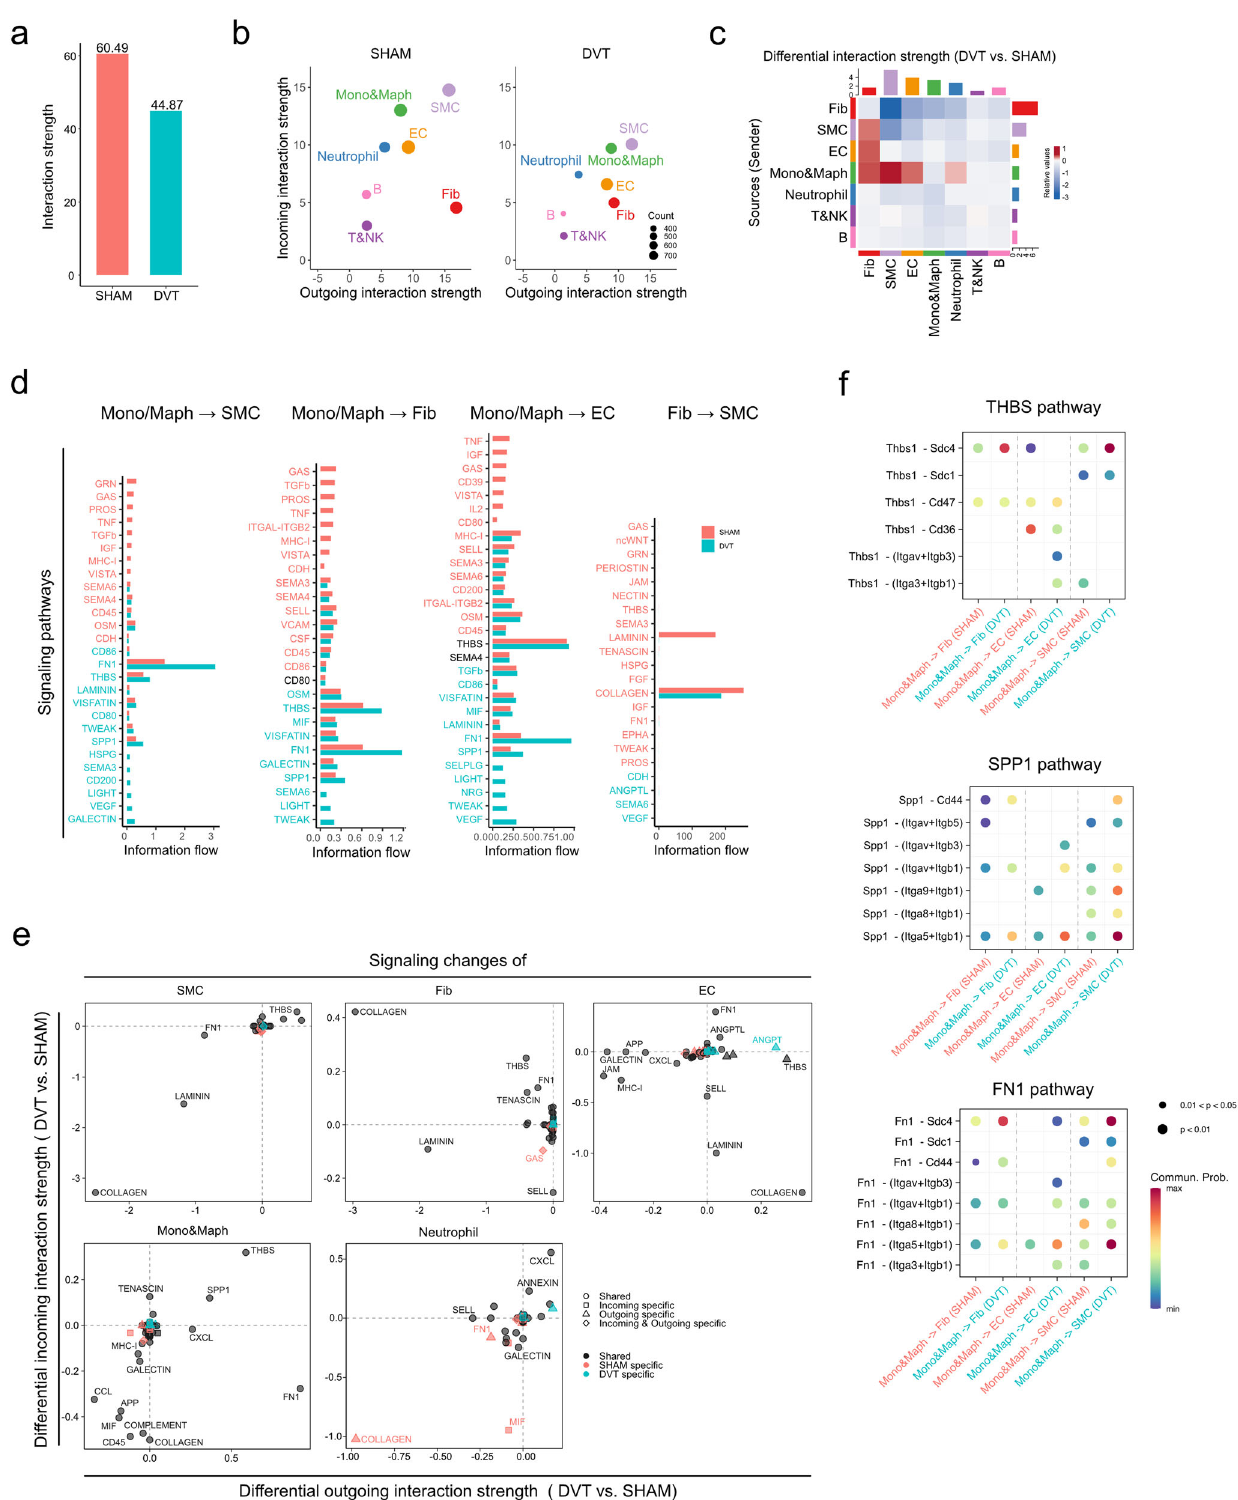
Fig. 6 Inferred cell-cell communication network in mouse DVT. a Total interaction strength in sham and DVT groups. b Scatter plot of incoming and outgoing interaction strength of each cell population in sham and DVT groups. c Heatmap of differential interaction strength in DVT compared to the sham group. The top-colored bar plot represents the sum of column of values displayed in the heatmap (incoming signaling). The right-colored bar plot represents the sum of row of values (outgoing signaling). In the heatmap, red (or blue) represents increased (or decreased) signaling in DVT compared to sham group. Relative value = the communication probability from source to target in DVT group — the communication probability from source to target in sham group. d Overall information fl ow of each signaling pathway in sham and DVT groups. e Signaling changes of major cell types in DVT compared to sham group. f Bubble plot of the communication probability of all the signi fi cant ligand-receptor pairs that contributed to THBS, SPP1, and FN1 signaling sent from monocytes and macrophages to vascular cell types in sham and DVT